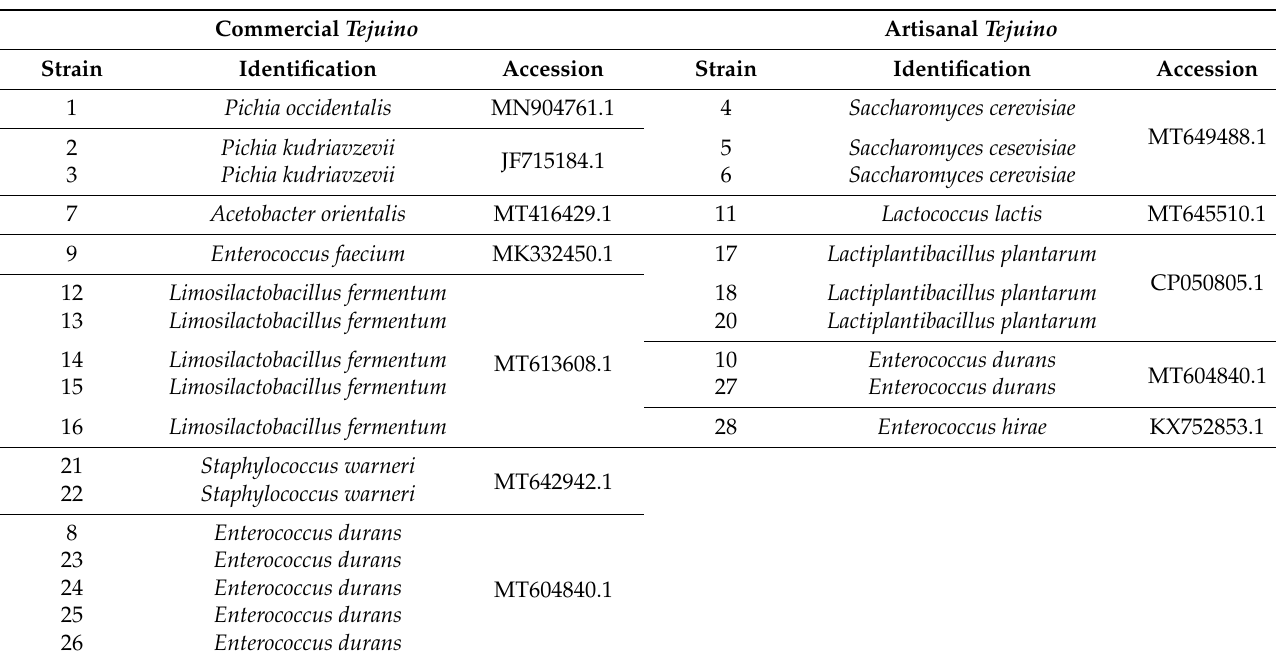
Table 3. Phylogenetic identification results of isolated yeasts and bacteria strains of commercial and artisanal Tejuino